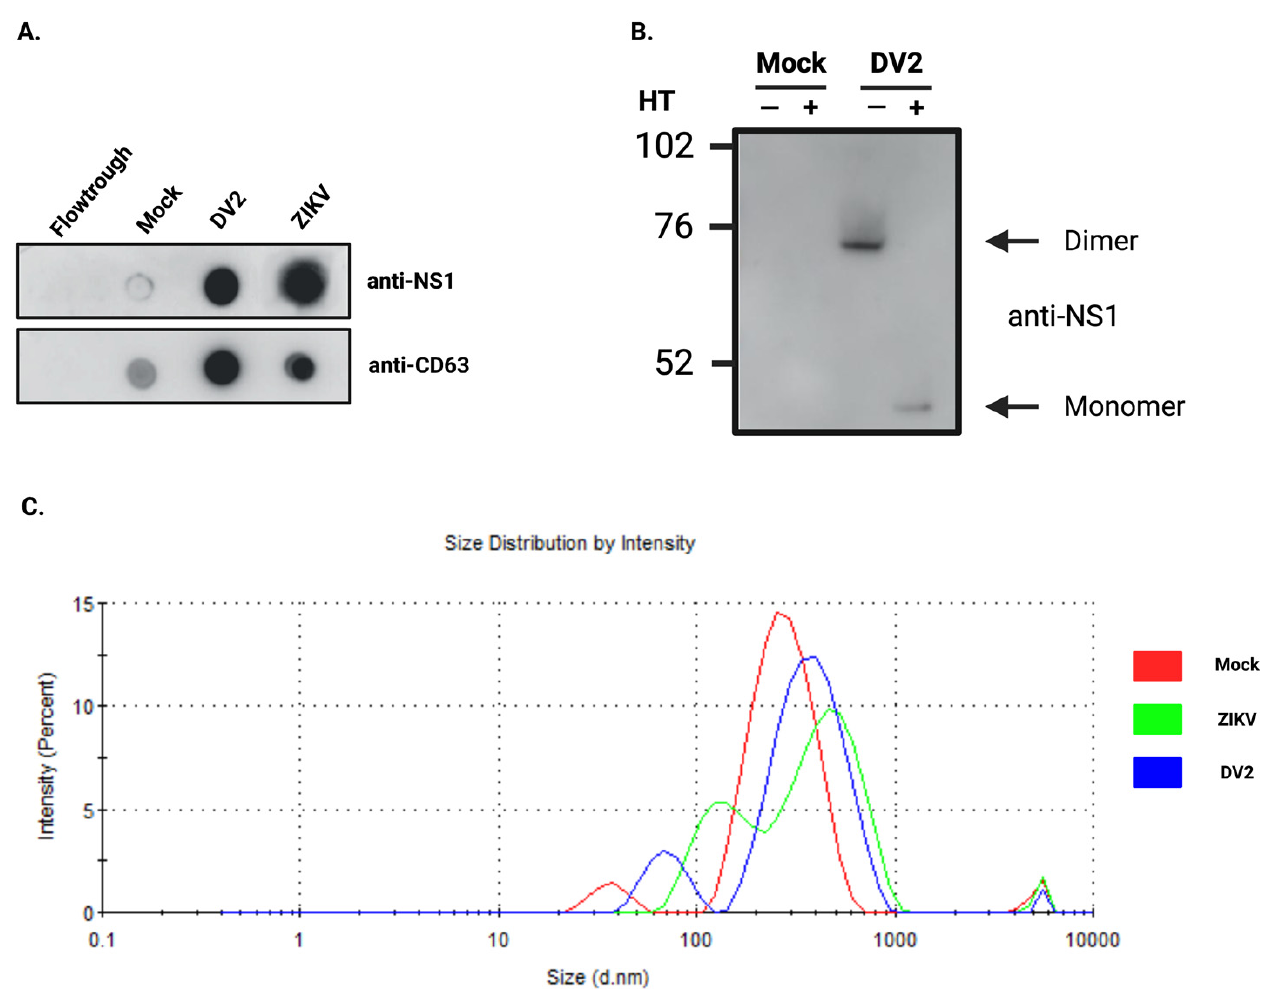
Figure 1. ZIKV and DENV2-infected A549 cells produce exosome-like particles associated with NS1 protein. ( A ) The NS1 protein of both ZIKV and DENV2 is found associated with the exosomal fraction obtained from the cell culture supernatants (CCS) of A549 infected cells. The tetraspanin CD63 detected on the dot blot of exosomal fractions provides insight into the quantity of exosomes extracted. ( B ) Western blot analysis of the exosome fraction, heated (HT) (+) or not ( − ), produced by DENV2 infected cells, show the presence of NS1 in dimeric form. A unique band with an apparent mass of ~48 kDa is observed after heating (+). ( C ) DLS analysis of exosomes produced by A549 cells during ZIKV (green) or DENV2 (blue) infection. On the y axis, the intensity gives the proportions of the different vesicle populations, depending on their size on the x axis. Both DENV2 and ZIKV infections appear to slightly reshape the distribution of vesicles. Table 1. Increased size of exosome during both ZIKV and DENV2 infection.